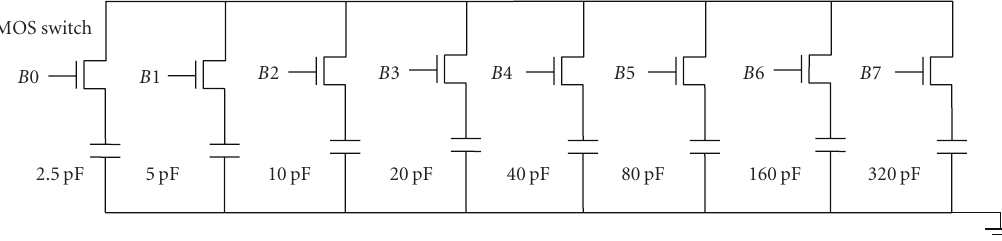
Figure 7: Binary-weighted programmable capacitor